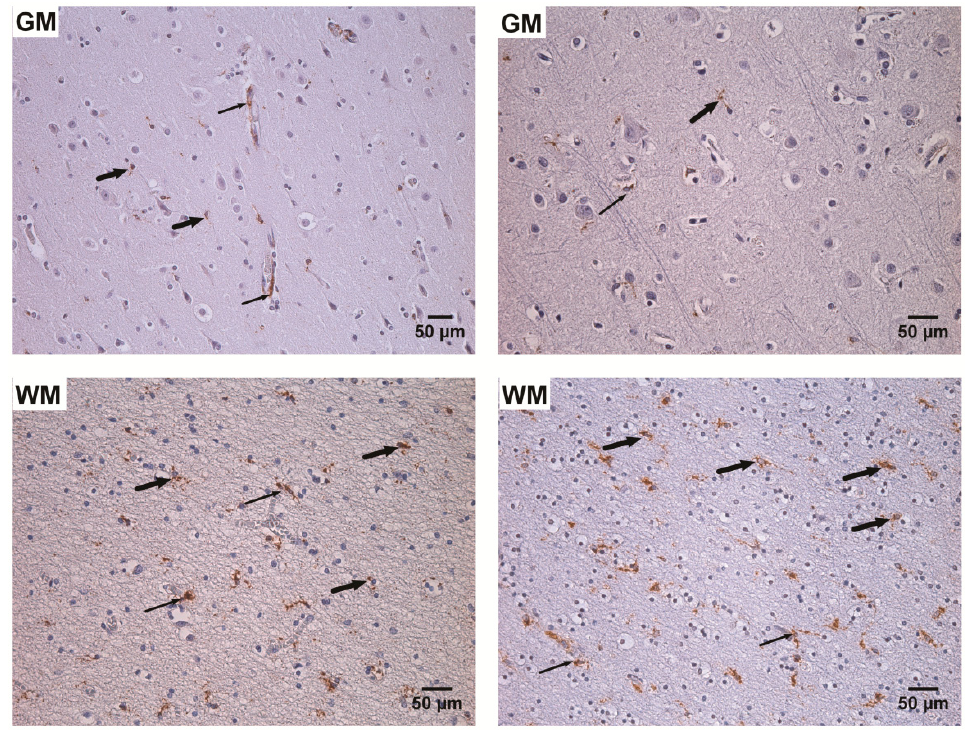
Figure 8. Detection of CD68 positive cells by routine immunohistochemistry (IHC), CD68 immunopositive products — brown. Left: frontal gray (GM) and white (WM) matter of the unspecified encephalopathy (UEP) subject demonstrating brown reaction products in the activated microglia/macrophages (perivascular (thin arrows) and diffuse (thick arrows) location), (200×, 250×); right: temporal gray (GM) and white (WM) matter of the UEP subject demonstrating brown reaction products in the activated microglia/macrophages (perivascular (thin arrows) and diffuse (thick arrows) location), (250×, 250×).